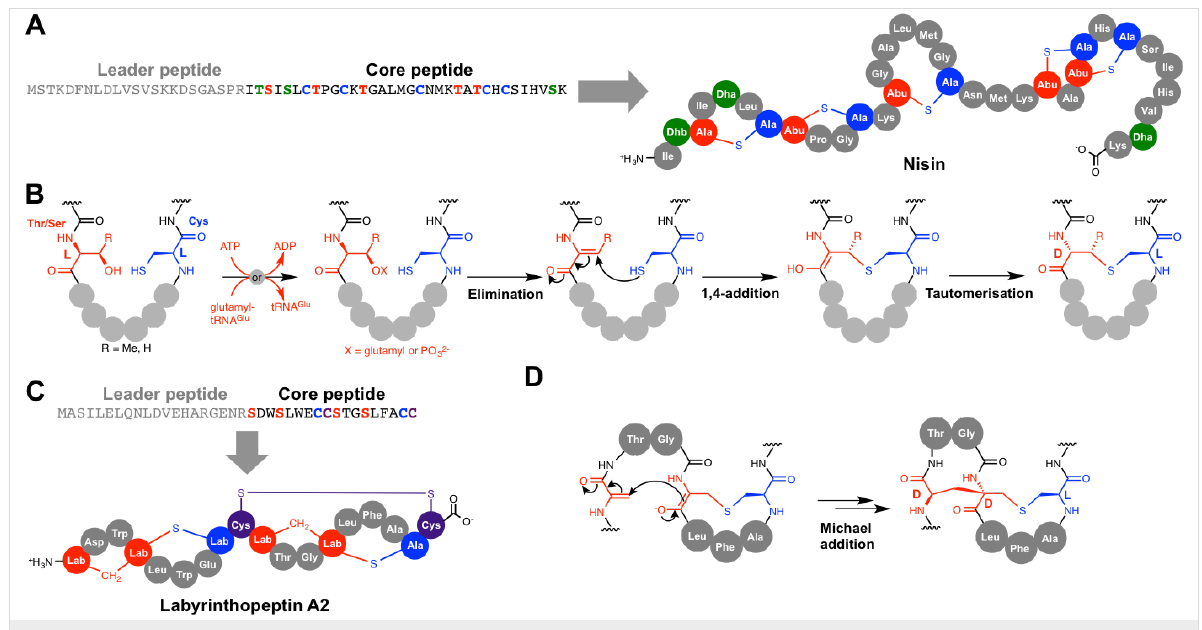
Figure 4: Lanthionine bond formation. A) Nisin and its precursor peptide. B) Mechanism of lanthionine bond formation for class I–IV lanthionine synthetases. GTP is used in an analogous way to ATP by some enzymes, for example in the biosynthesis of labyrinthopeptin A2. C) Labyrinthopeptin A2 and its precursor peptide. D) Mechanism for labionin formation in the biosynthesis of labyrinthopeptin